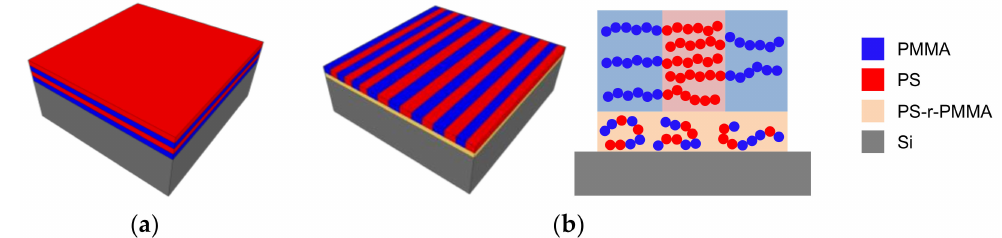
Figure 1. Schematic of the self-assembly of lamellar PS-b-PMMA. ( a ) If the substrate shows preferential interaction with PS or PMMA, self-assembly in horizontal lamellae guarantees minimal free energy at the interface; ( b ) a random copolymer brush (PS-r-PMMA) can be used to impel neutral a ffi nity to the substrate, coercing the generation of vertical PS and PMMA